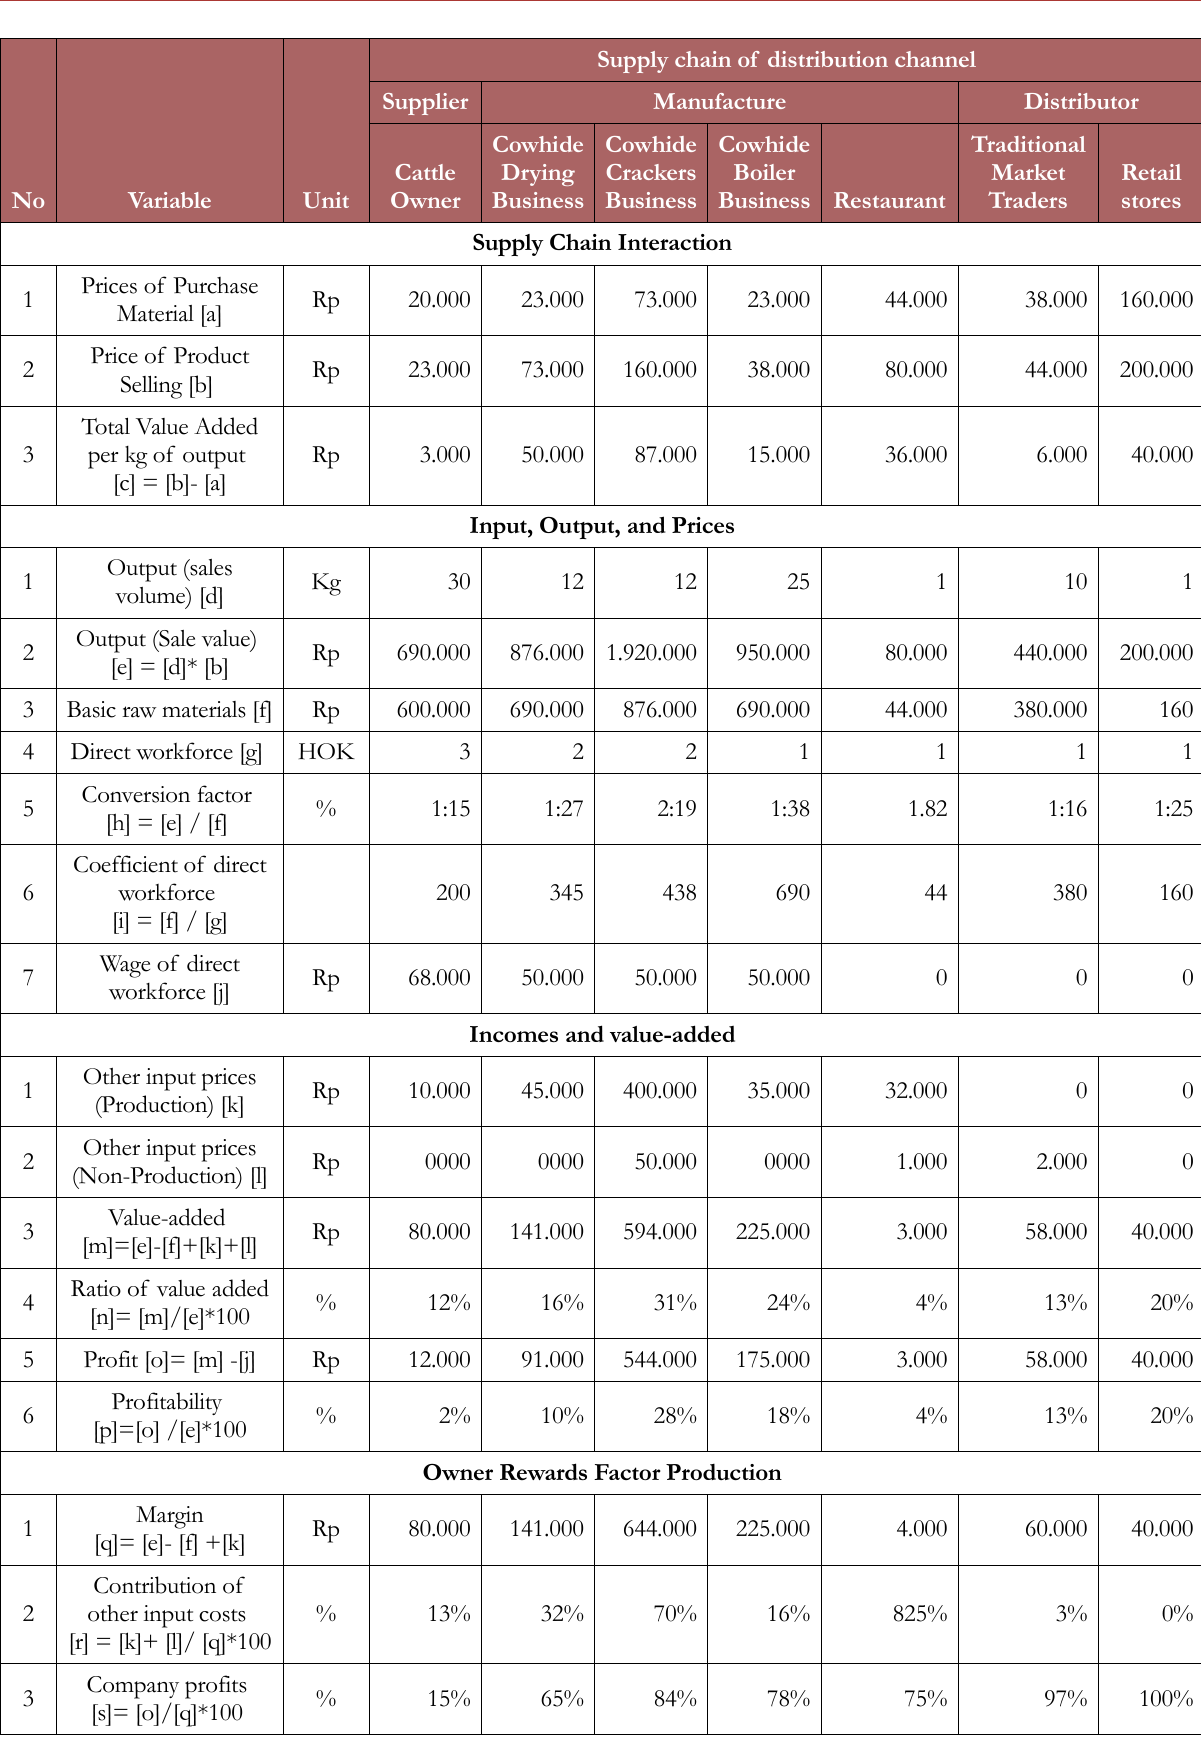
Table 1. Value-added food product of